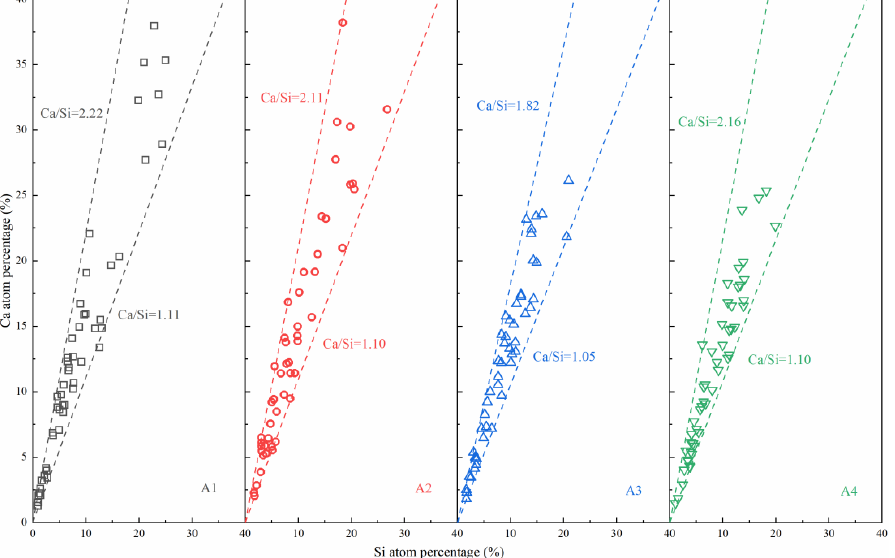
To investigate the difference in C–S–H gels between four pastes, fifty points were